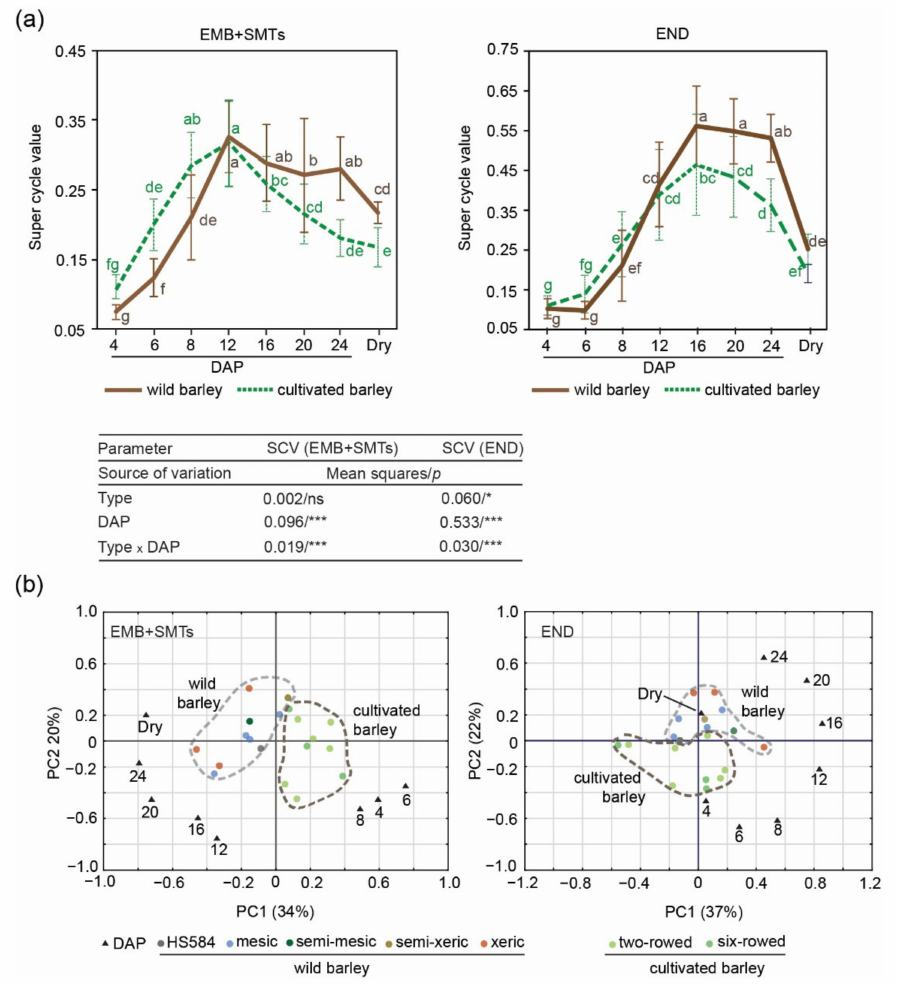
Figure 5. Comparison of the super cycle values (SCVs) for diploid seed tissues (EMB + SMTs) versus triploid endosperm (END) at given DAP between wild and cultivated barley. ( a ) Mean SCVs of EMB + SMTs and endosperm. Wild barley is represented by ten accessions (solid brown lines). Cultivated barley includes six two-rowed and three six-rowed cultivars (dashed green lines). Data for six-rowed cultivars are presented in Supplementary Figure S4. Data are the means ( ± SD) from three biological replicates, each with at least 5 individual measurements (Source data are presented in Supplementary Table S5). Data marked with the same letter do not differ according to the Duncan test ( p ≤ 0.05). The sources of variance were as follows: two types of barley (wild and cultivated), eight-time point (DAP), and interaction between type and DAP. *, *** Significant at p ≤ 0.05, 0.001, respectively; ns—not significant. ( b ) Principal component (PC) analysis of SCVs in wild and cultivated barley. Numbers in the plots indicate DAP. The positions represent the contribution rates of the two main PCs to a given character. The dashed-line areas were added to highlight sample